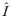
Hierarchical networks produce distinct decision regimes.I: input; I^: input normalized by the reference choice alternative values’ linear sum; T: transform layer synaptic gating variable; P(A): proportion of 1,000 trials where alternative A was chosen; J+: excitatory weight; J−: inhibitory weight; yellow: varied weights; forest green: regime II; tan: regime I; sky blue: regime III. The first subscript indicates choice A or B, and the second subscript x indicates a generic attribute. Weights were systematically varied identically in all intermediate layer areas. (A) A diagram of a generic intermediate layer area and its inputs. (B) The Hierarchical Network produced expected psychometric functions. (C) Modification of intermediate layer E/I tone produced distinct indifference curve regimes. Examples of regime I (linear), regime II (convex) and regime III (concave) decision regimes. (D) The space of E/I tones can be partitioned by decision regime according to their indifference curves.